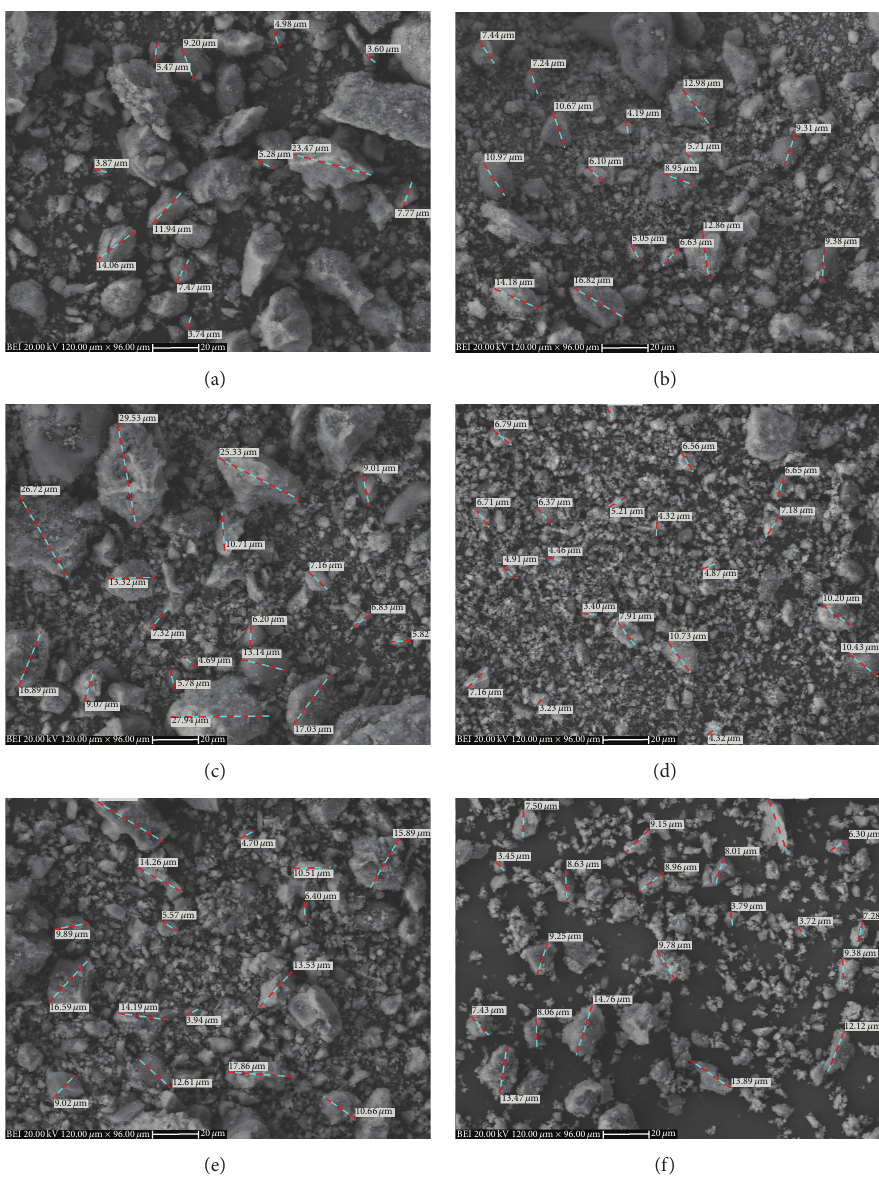
Figure 5: SEM photos of the synthesized dehydrated magnesium borate minerals, magnification of 1000x; (a) 800 ∘ C-1: 1, (b) 800 ∘ C-3: 2, (c) 900 ∘ C-1:1, (d) 900 ∘ C-3: 2, (e) 1000 ∘ C-1: 1, and (f) 1000 ∘